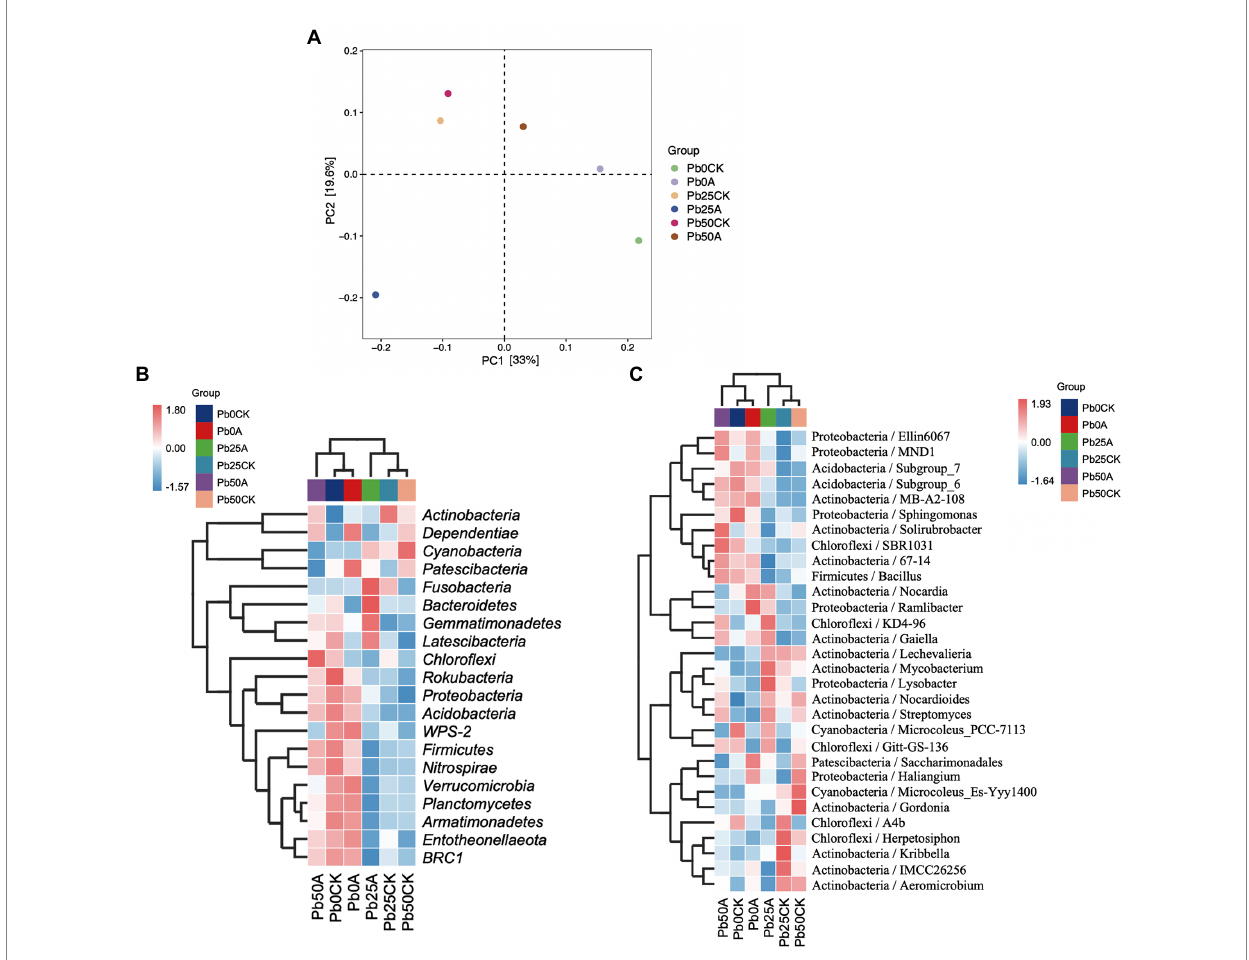
FIGURE 6 Principle coordinates analysis (PCoA) showed a pattern of inoculation grouping based on the weighted UniFrac distance of all communities. Each colored dot represents a treatment (A) . The heatmap of the top 20 phylum (B) and top 30 genera (C) in the rhizospheric soil of pakchoi with different Pb concentrations. The relative values for each bacterial phylum or genera were depicted by color intensity according to the legend at the top right corner of the